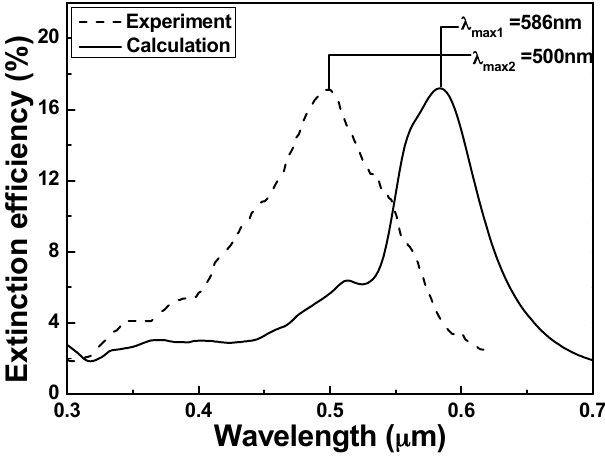
Figure 10. LSPR spectra comparing the simulation result and the measured response of square lattice of quadrate periodic nanoparticle arrays.